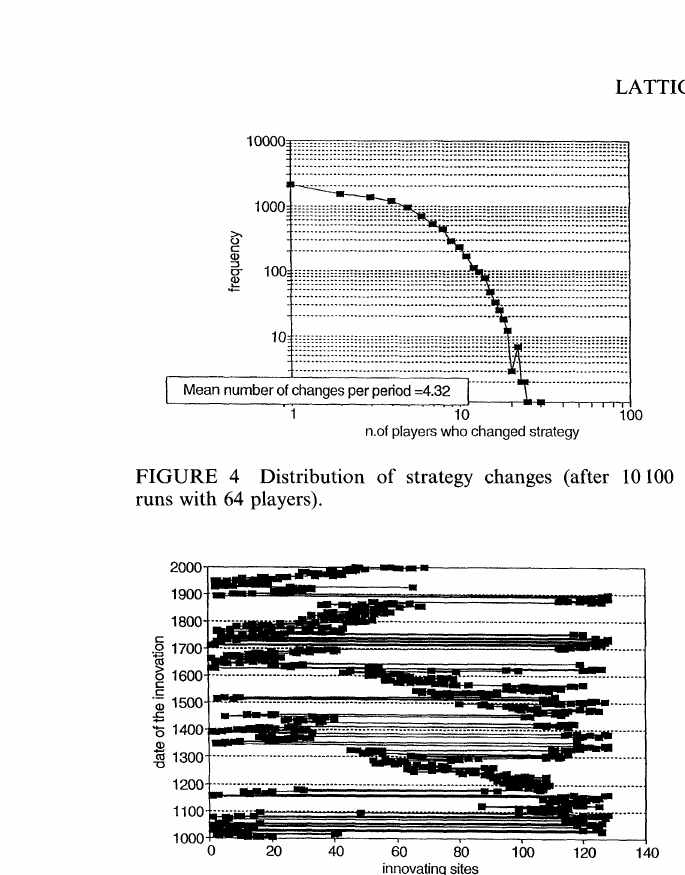
FIGURE 5 Localization of the innovations (1000